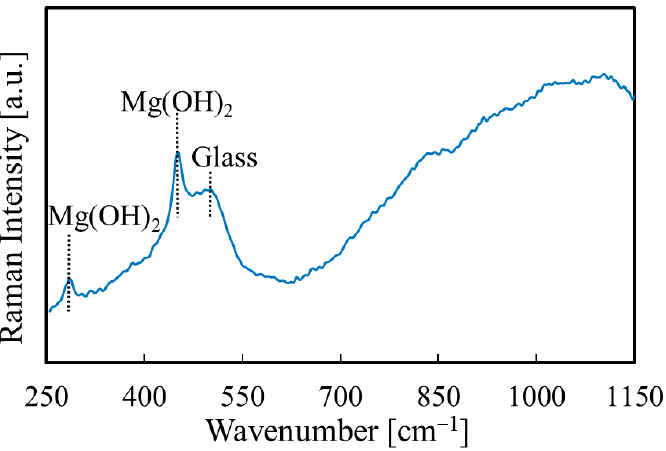
Figure 8. Raman spectrum of the Mg(OH) 2 film.